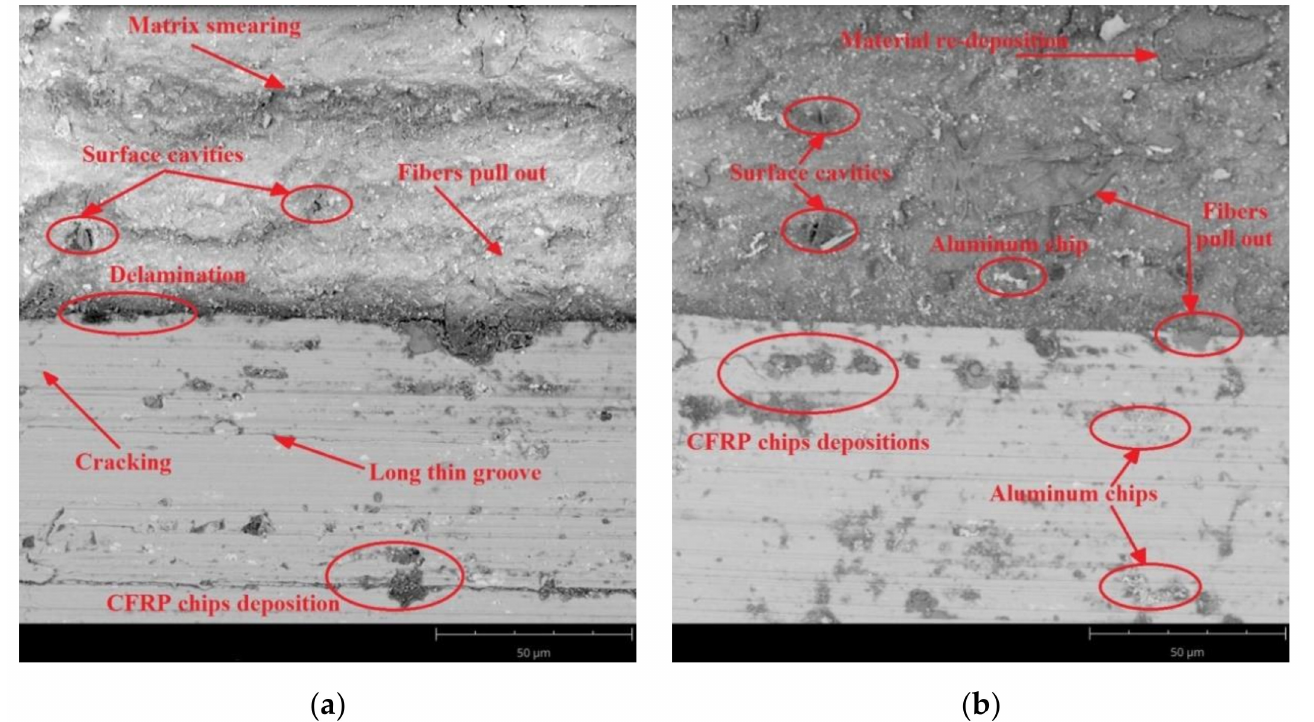
Figure 13. SEM images of aluminium alloy and CFRP surfaces after milling at a feed rate of f z = 0.12 mm/blade and using strategy: ( a ) Al/CFRP, ( b )